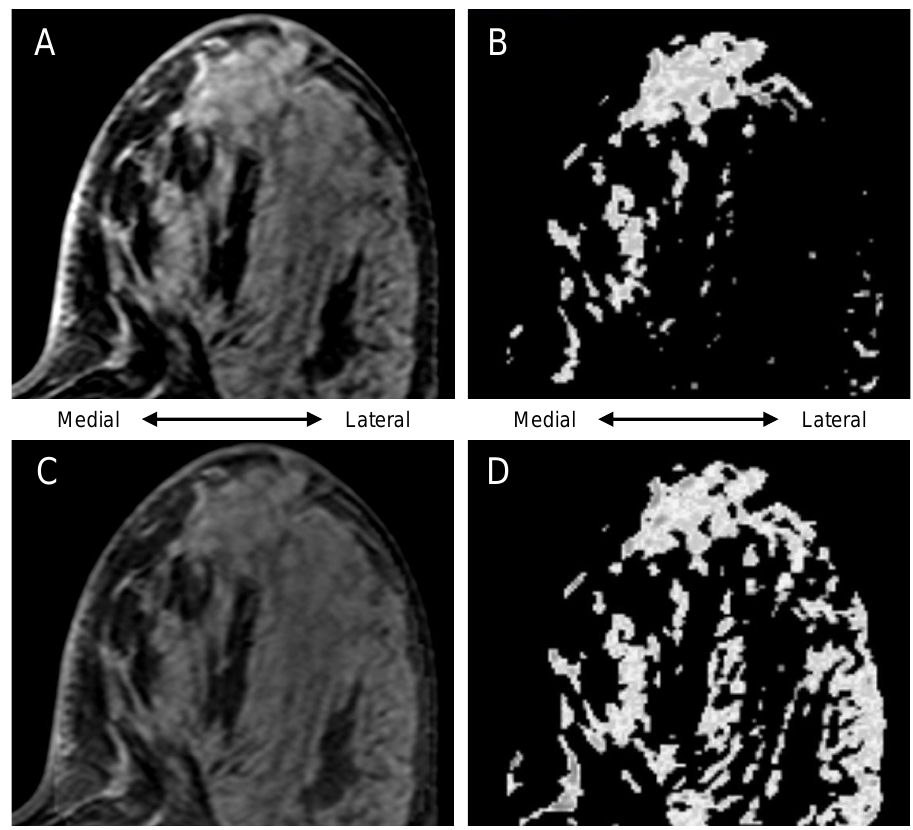
Figure 4. Representative section of a case: ( A ) uncorrected pre-contrast image, ( B ) uncorrected BPE mask (voxel count, 145049; BPE measurement, 24.0), ( C ) bias-corrected pre-contrast image, ( D ) bias-corrected BPE mask (voxel count, 186266; BPE measurement, 32.5).